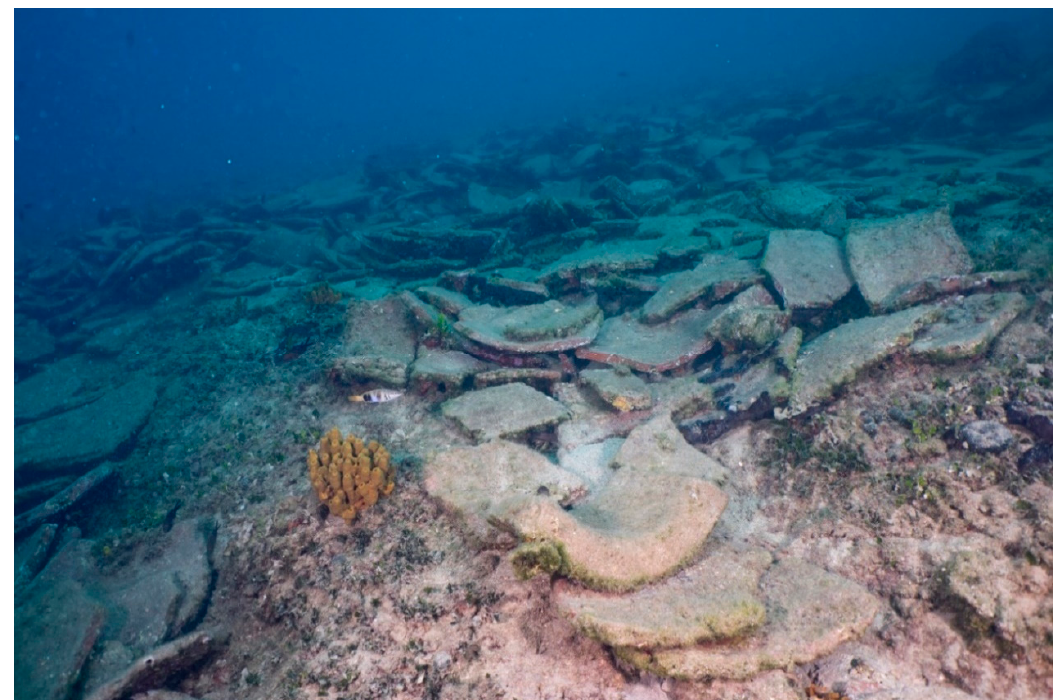
Figure 8. The accessible underwater archaeological site of “Kikinthos” shipwreck (Amaliapolis). ©MCS-EUA, photo by Matteo Collina, Università della Calabria—DIMEG.